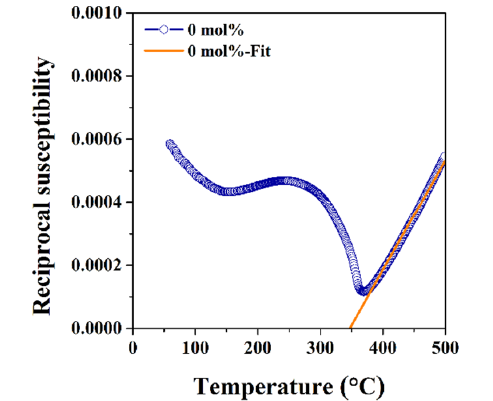
Figure 4. Variation of the phase transition temperatures for NKLNTS-ST- x CuO ceramics measured at 100 kHz.